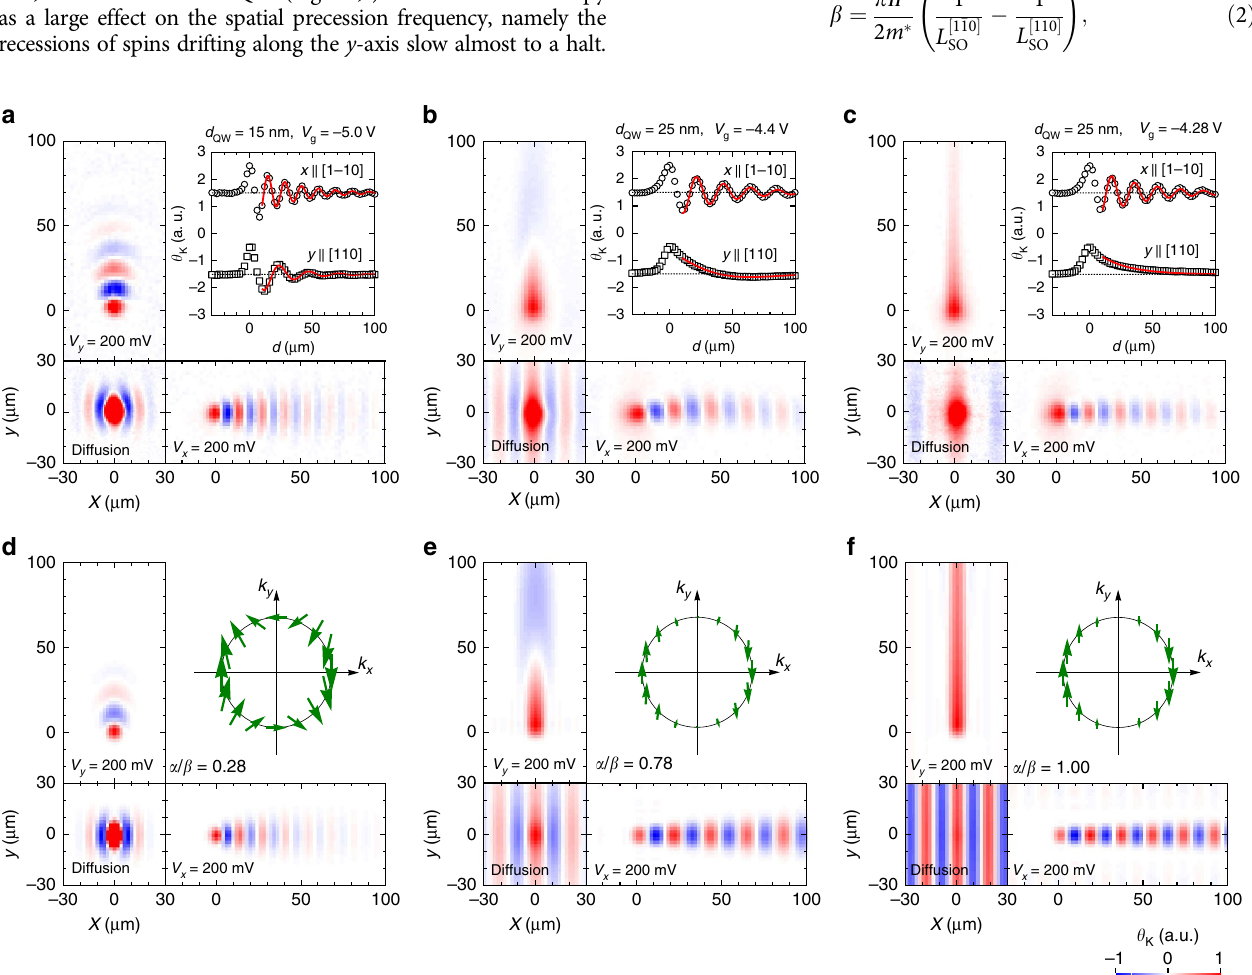
Figure 2 | Mapping of spins with/without in-plane electric fields. ( a – c ) Kerr rotation image of spins with/without in-plane electric fields in 15-nm-thick QW at V g ¼ (cid:2) 5.0V ( a ), and 25-nm-thick QW at V g ¼ (cid:2) 4.4V ( b ) and (cid:2) 4.28V ( c ). Insets are cross-sectional patterns of drifting spins in the x and y directions. ( d – f ) Spatial mapping of drifting spins simulated by SDD model, corresponding to a – f . Insets show effective magnetic fields in k -space for given SOI